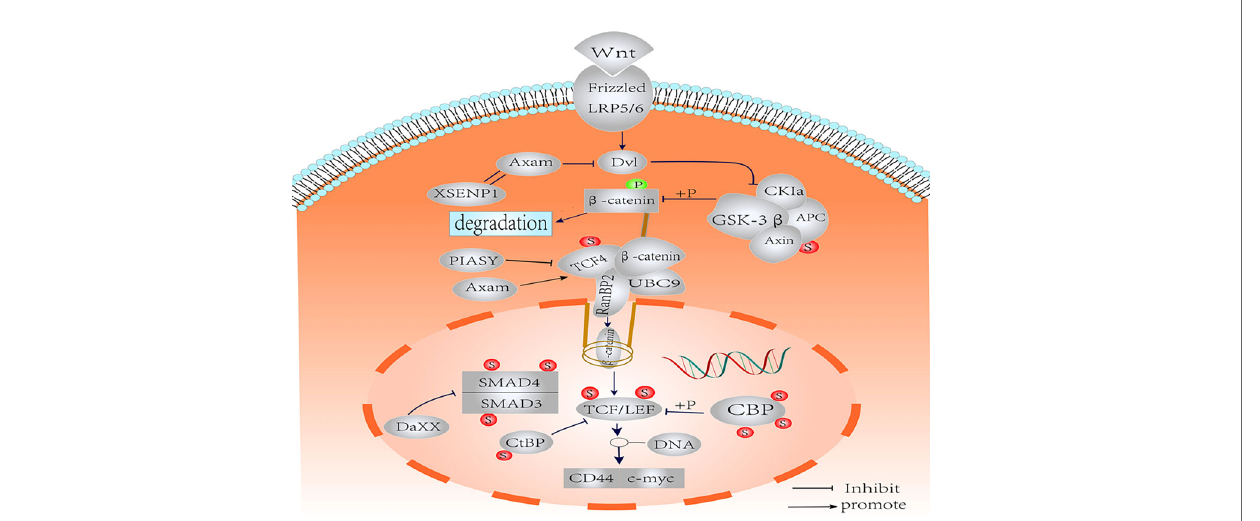
FIGURE 2 | Schematic representation of the SUMOylation on the components of Wnt/ b -catenin pathways. Nuclear translocation of b -catenin is regulated by SUMO. The SUMOylation of TCF-4 increases the activity of TCF-4. SUMOylated TCF promotes the binding of b -catenin to RanBP2 of the nuclear pore complex into the nucleus. SUMOylation of GSK-3 b improves kinase activity and protein stability. The SUMOylation of LEF1 and its co-expression with PIASy resulted in effective inhibition of LEF1 activity. The SUMOylation of Axin had no effect on Wnt signaling. Axam acts as deSUMOylated enzyme to downregulate b -catenin and implicates the negative regulation of Wnt signaling pathway. SUMO modi fi cation negatively regulates CBP transcriptional activity by recruiting Daxx. The CBP may act as the SUMO E3 ligase enzyme, which promotes intramolecular SUMOylation of adjacent CRD1 domains. Binding of CtBP1 to SUMO increases nuclear accumulation. Smad3 SUMOylation is enhanced in the presence of PIASy, resulting in translocation to the cytoplasm. Under the in fl uence of PIASy, PIAS1, PIASx a , and PIASx b , SUMOylation reduces the stability and transcriptional activity of Smad4, but the effect on Wnt/ b -catenin is not clear.